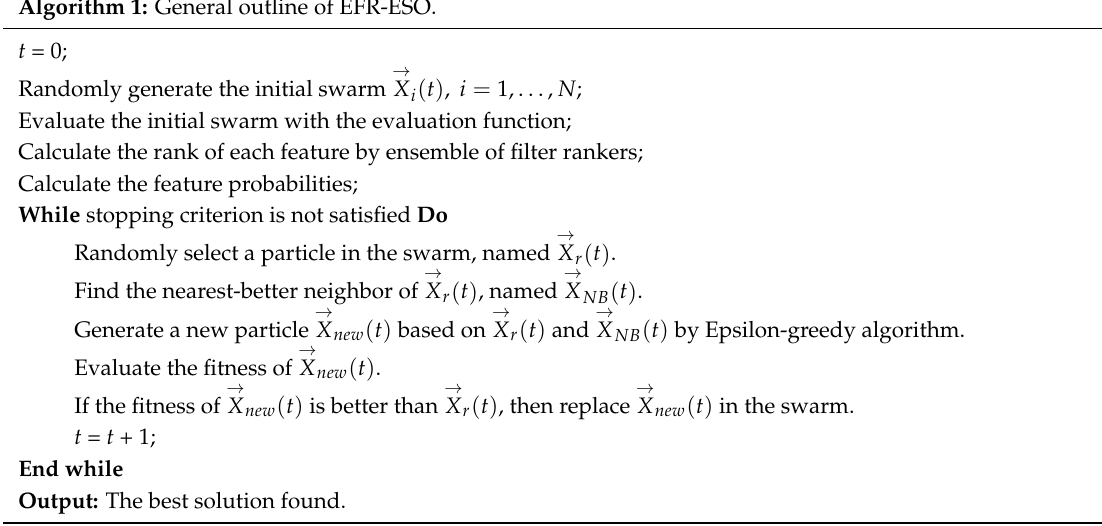
Algorithm 1: General outline of